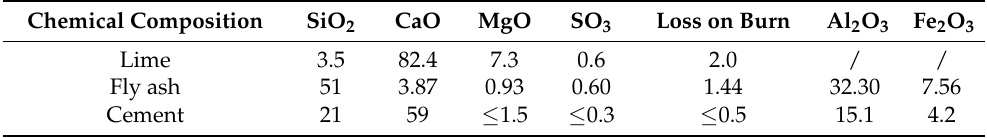
Table 2. Chemical composition of inorganic improvers.